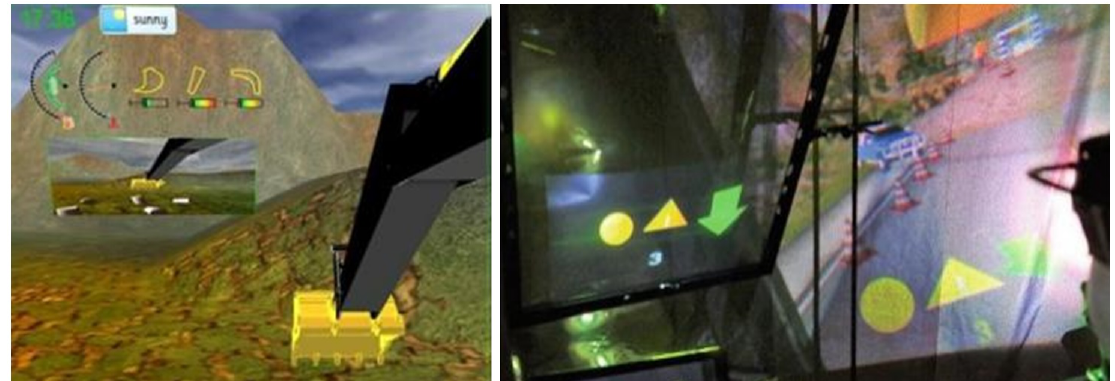
Figure 2. The left image shows machine-related status, which is directly presented on the virtual windshield inside the virtual environment [13]. The right image shows navigational information and collision warning that are projected on a physical windshield inside the mixed reality environment